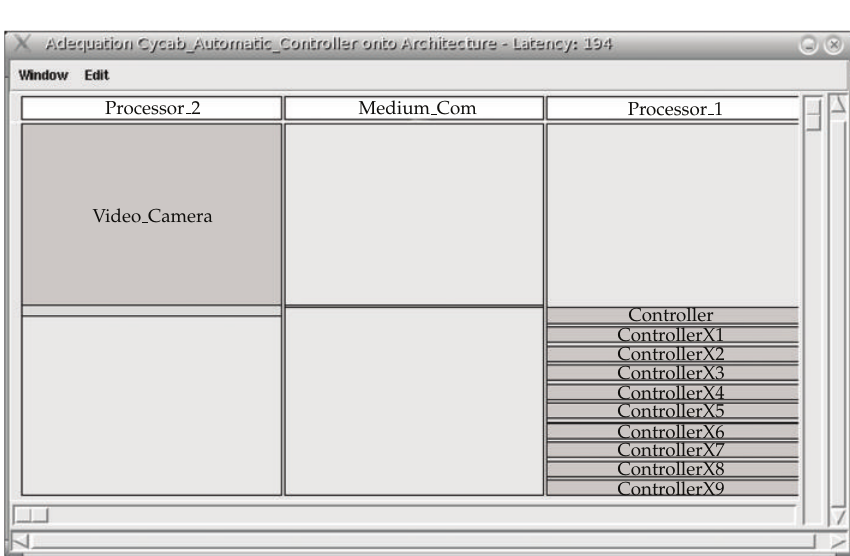
Figure 6: Platooning application (cid:3) distribution and scheduling (cid:4)